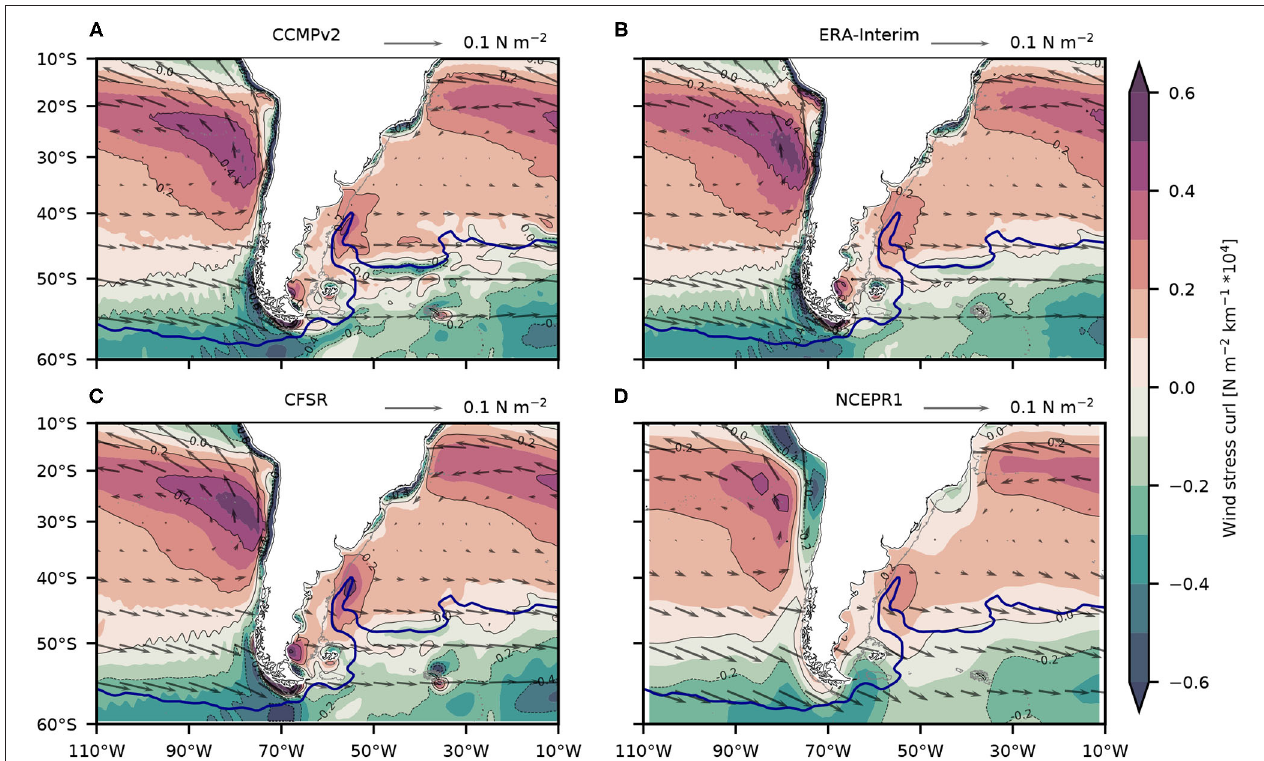
FIGURE 2 | Distribution of climatological wind stress at 10 m height (vectors) and wind stress curl (background shading) during 1988–2017 from (A) CCMPv2, (B) Era-Interim, (C) CFSR, and (D) NCEPR1. Wind data are described in Section 2.2. Positive wind stress curl indicates anticyclonic wind stress circulation and negative wind stress curl indicates cyclonic circulation. Vectors are shown every 20 gridpoints for CCMPv2 and ERA-Interim, every 10 gridpoints for CFSR and every 3 gridpoints for NCEPR1. The solid dark blue line represents the mean location of the Subantarctic Front (SAF, Kim and Orsi, 2014).